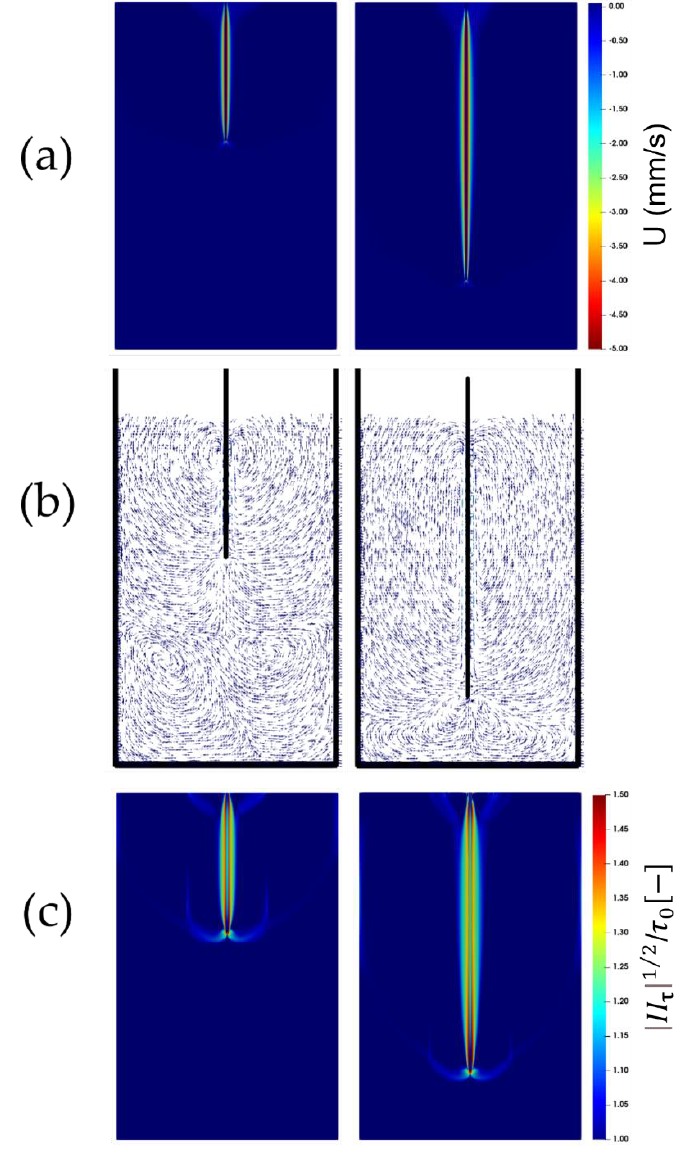
Figure 5. Snapshots of the flow for the plate immersion velocity of 5 mm/s. The top contour plots are ( a ) the fluid velocity, and ( c ) the bottom contours are the square root of the second invariant of the viscous stress tensor compared to the yield stress τ 0 . The middle vector ( b ) fields show the velocity vectors within the domain.